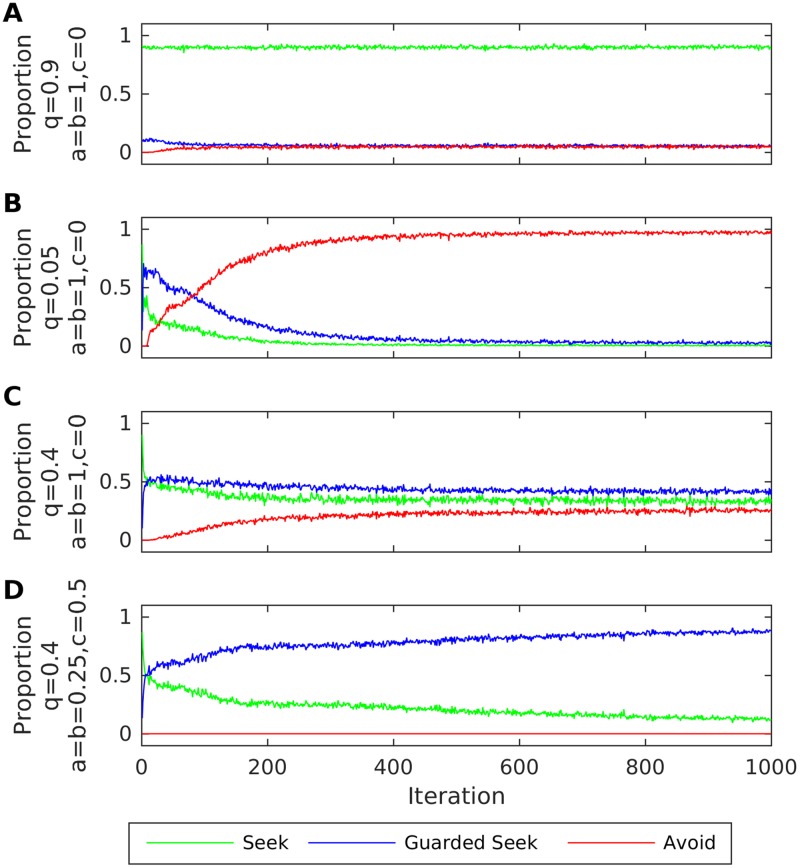
Secure, avoidant and ambivalent attachment with additional exteroceptive cues.This figure illustrates the mean (over repetitions) proportion of actions selected. A: Proportions for an infant paired with a highly responsive caregiver (q = 0.9) with no ACEs (a = b = 1, c = 0). B: Proportions for an infant paired with a highly unresponsive caregiver (q = 0.05) with no ACEs (a = b = 1, c = 0). C: Proportions for an infant paired with an inconsistent caregiver (q = 0.4) with no ACEs (a = b = 1, c = 0). D: Proportions for an infant paired with an inconsistent caregiver (q = 0.4) with both ambiguous and misleading ACEs (a = b = 0.25, c = 0.5).